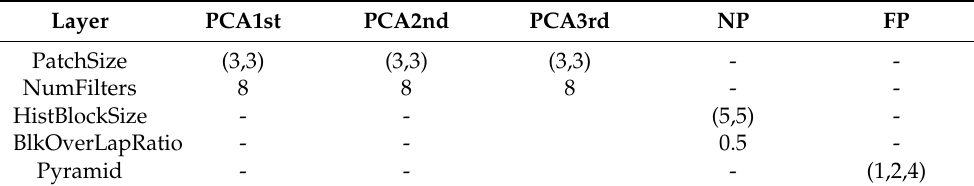
Table 8. Network structure of the Baffin Bay data set.